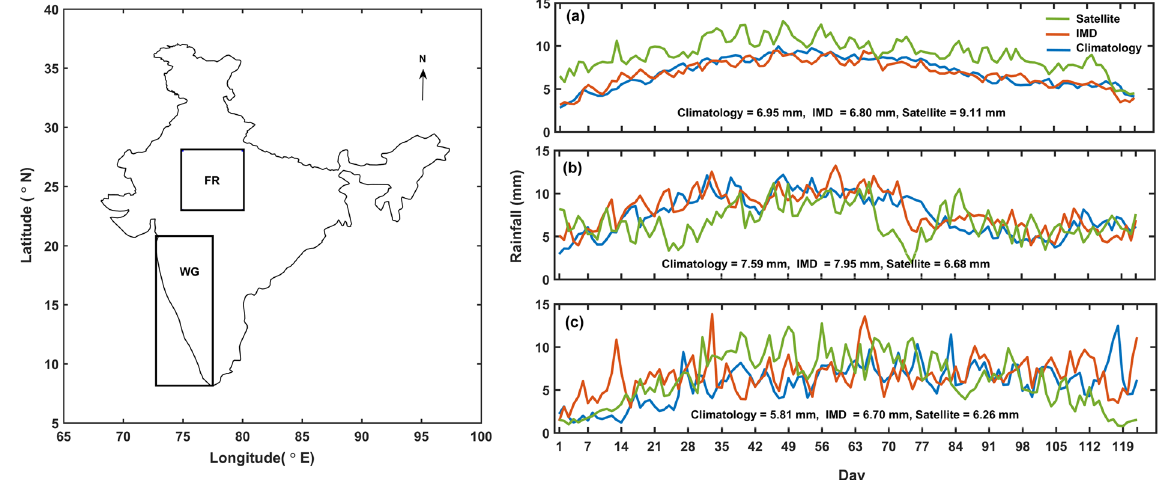
Figure 2. Study area (left panel) and Time series plot of daily rainfall ( a ) all India, ( b ) WG and ( c ). FR from 1998–2016 (right panel).